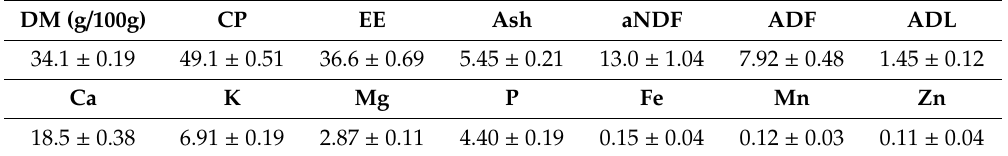
Table 1. Nutritional (g / 100 g dry matter (DM), unless stated) and mineral composition (g / kg DM) of untreated black soldier fly larvae (BSFL) reared in brewer’s by-product (mean ± standard deviation). DM (g / 100g) CP EE Ash aNDF ADF ADL 34.1 ± 0.19 K Mg P Fe Mn